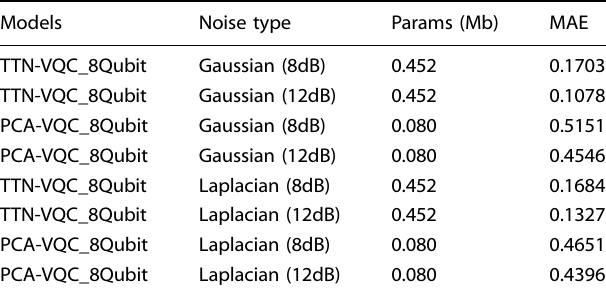
Fig. 6 Empirical results of the vector-to-vector regression on the MNIST dataset to evaluate the generalization power of TTN-VQC and PCA-VQC with 8 qubits. a MAE loss values on the training data. b MAE loss values on the test data. There are two noisy settings on the test dataset to evaluate the performance of the TTN-VQC and PCA-VQC models: Gauss-8dB and Gauss-12dB separately denote the Gaussian noisy conditions of 8 dB and 12 dB SNR levels; Laplace-8dB and Laplace-12dB refer to the Laplacian noisy settings of 8dB and 12dB SNR levels, respectively. Table 4. Empirical results of TTN-VQC on datasets of different Table 3. Empirical results of TTN-VQC and PCA-VQC models on the test dataset with either Gaussian or Laplacian noise with 8 dB or 12 dB SNR levels.